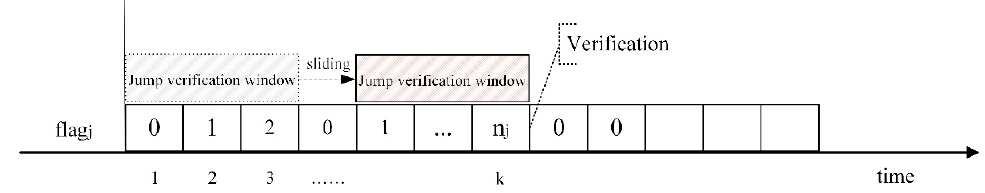
Figure 3. GNSS jump verification.